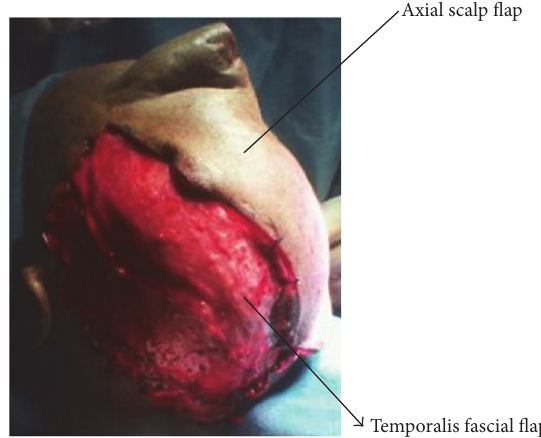
Figure 4: Temporoparietal flap and the axial scalp flap utilized to cover the exposed bone.